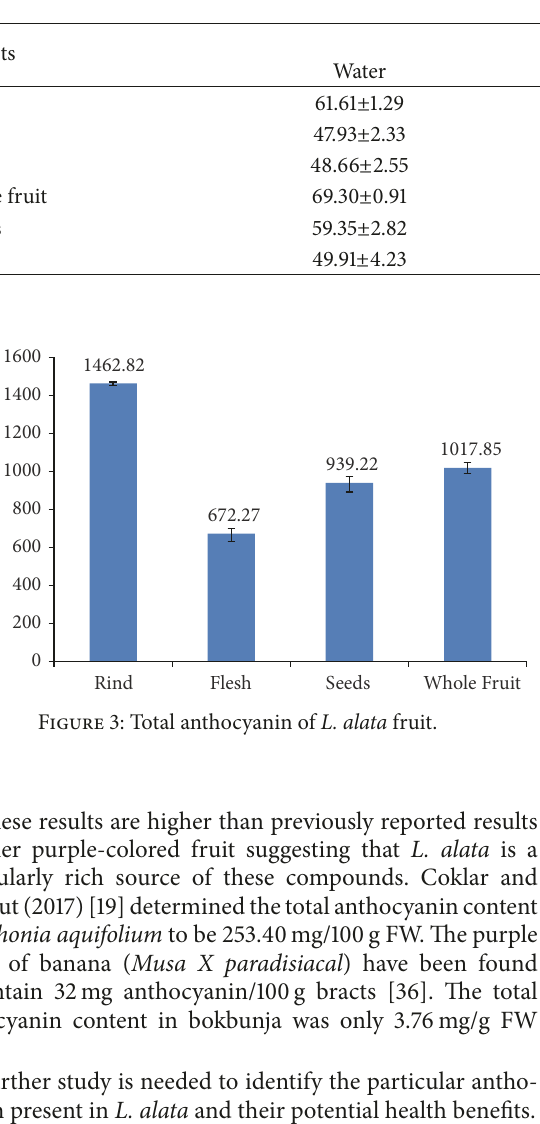
Table 2: DPPH radical scavenging activity of L. alata .